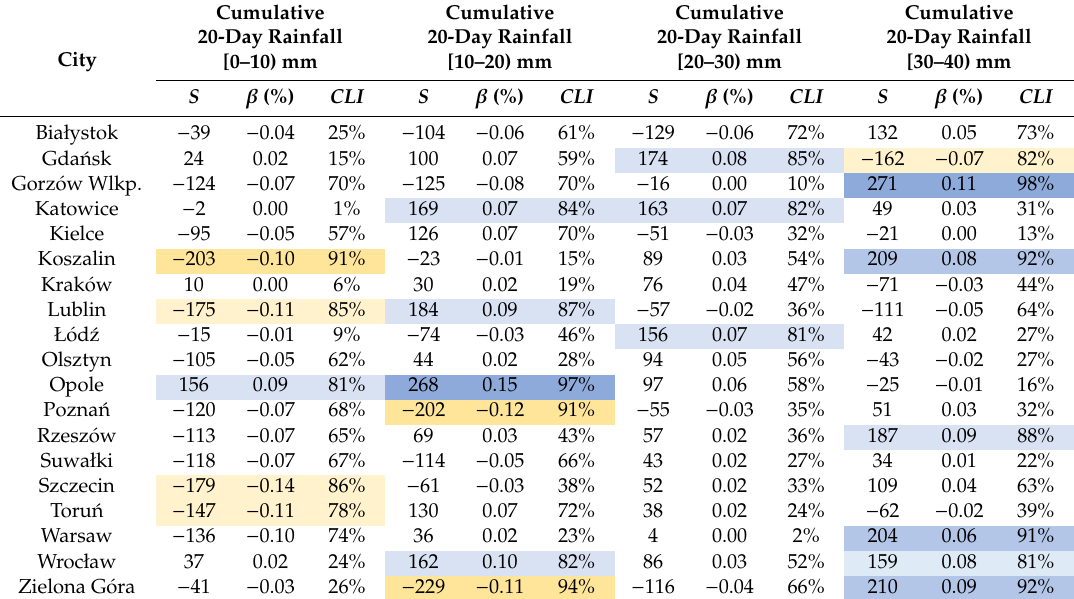
Table 5. Trend detection parameters for 20-day cumulative rainfall for the di ff erent class intervals under study, during the period